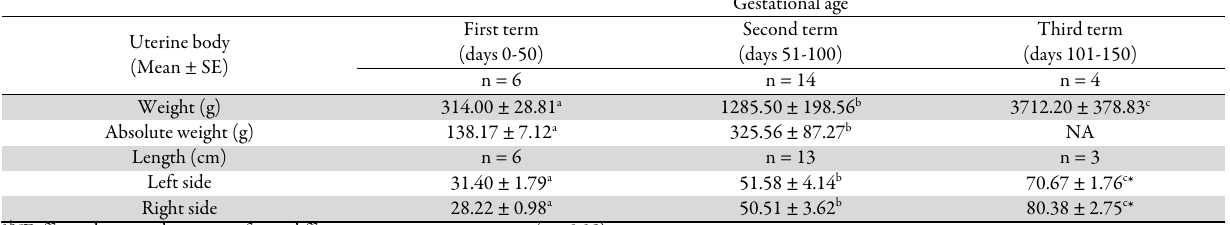
Table 1.The mean biometrics of pregnant uteri of Maradi doe goat per-term